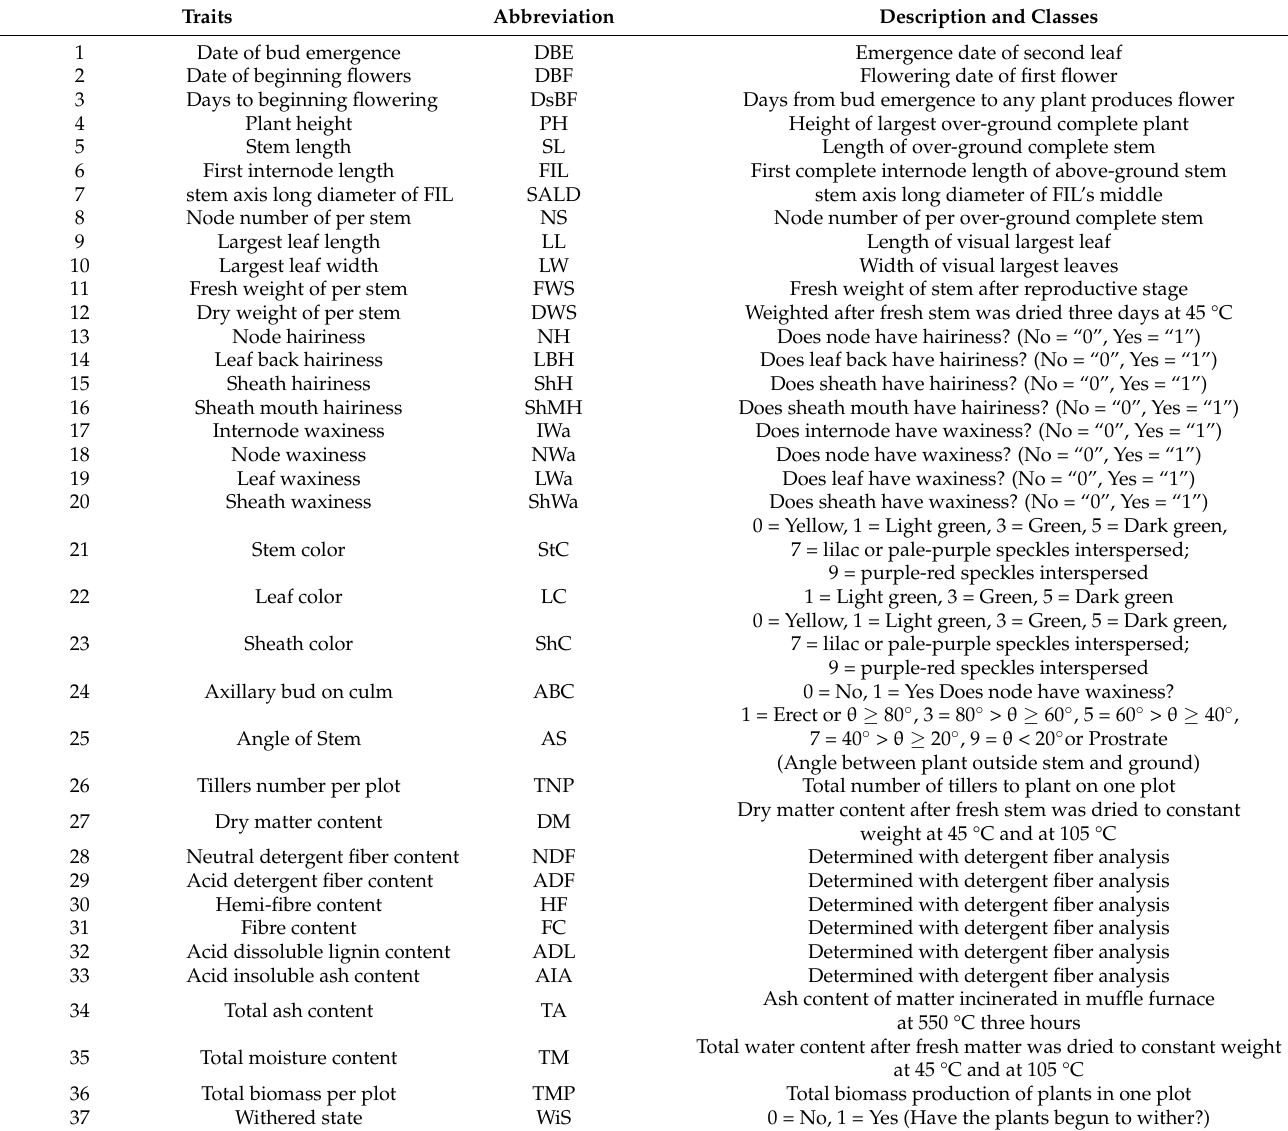
Table 1. The description and classes of the Miscanthus Phenotypic